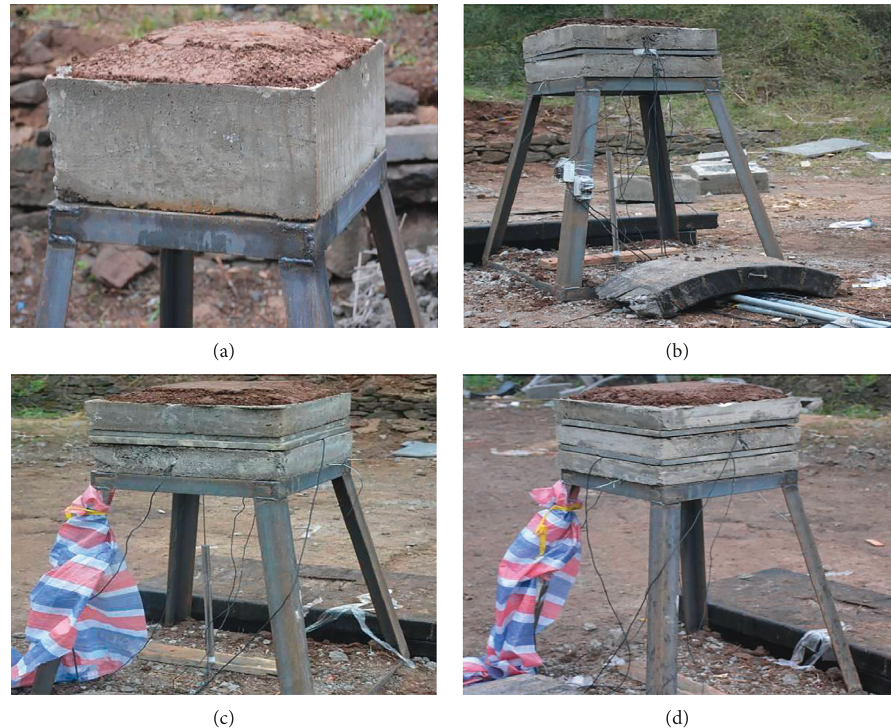
Figure 6: Experimental test setups. (a) Test 1. (b) Tests 2 and 3. (c) Test 4. (d) Test 5.